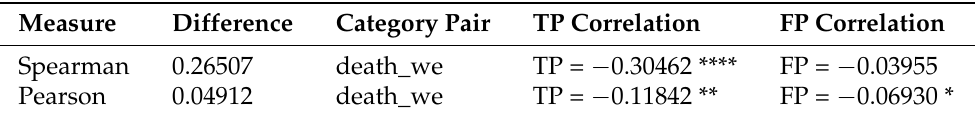
Table 25. Death and 1st person plural in High.